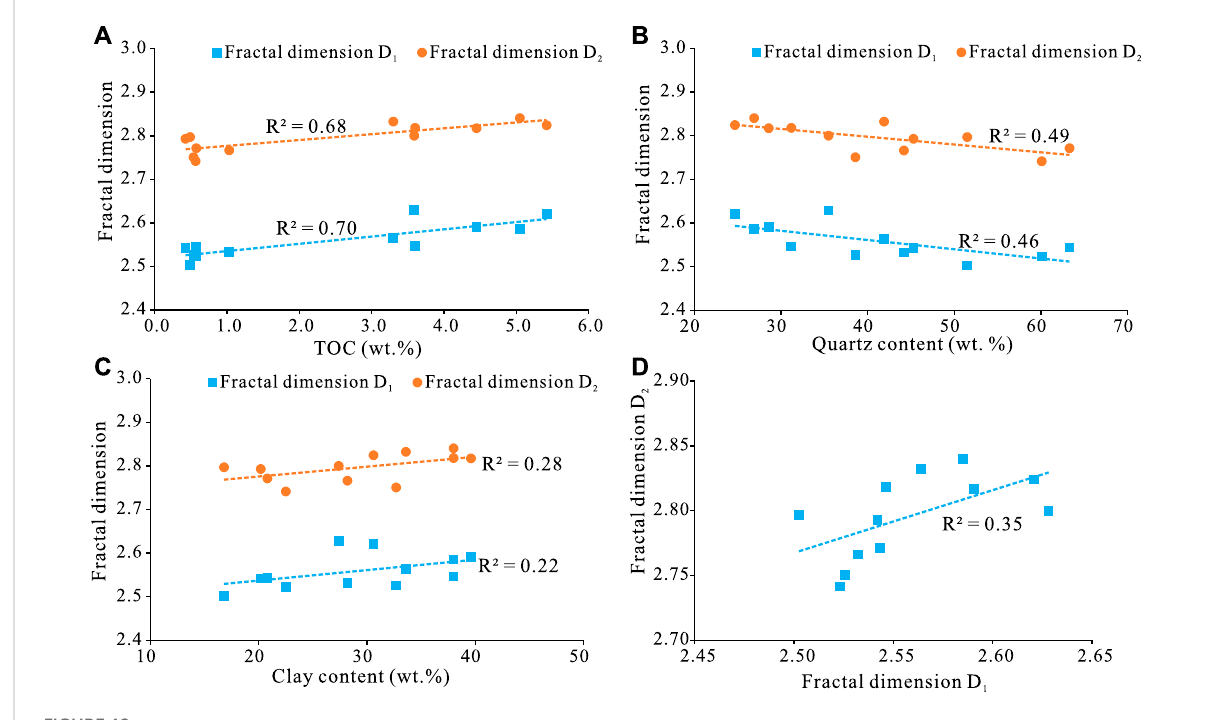
FIGURE 12 Relationships between the shale composition and fractal dimensions (D1 and D2) [ (A) : TOC vs D1 and D2; (B) : quartz content vs D1 and D2; (C) : clay content vs D1 and D2; (D) : D1 vs D2].